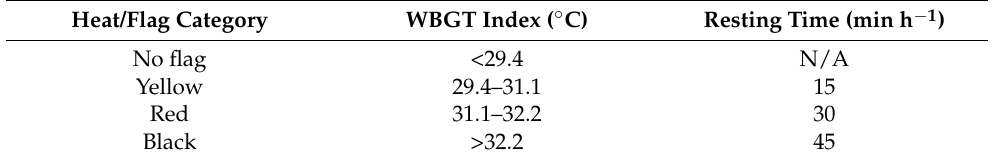
Table 1. WBGT heat category and corresponding rest time per hour.